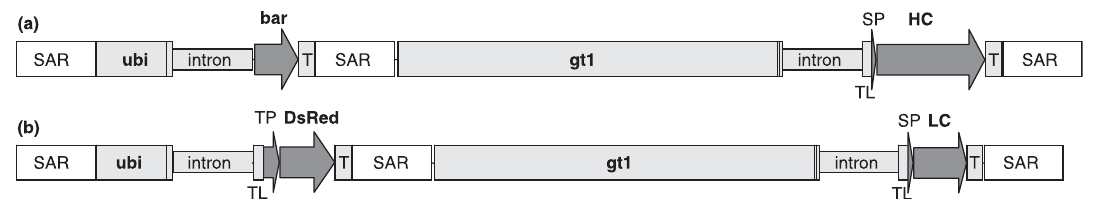
Figure 1 Plant expression cassettes in pTRAb-gGHER (a) and pTRAds-gGLER (b). bar, bialaphos resistance; DsRed, red fluorescent protein from Discosoma sp.; gt1, rice glutelin-1 promoter; HC and LC, coding sequence of heavy and light chain of the 2G12 antibody with endoplasmic reticulum (ER) retention signal; intron, intron1 of the maize ubiquitin-1 promoter; SAR, scaffold attachment region; SP, signal peptide; T, terminator of the cauliflower mosaic virus (CaMV) 35S gene; TL, 5 ′ -untransformed region (5 ′ -UTR) of the tobacco etch virus; TP, transit peptide; ubi, maize ubiquitin-1 promoter.